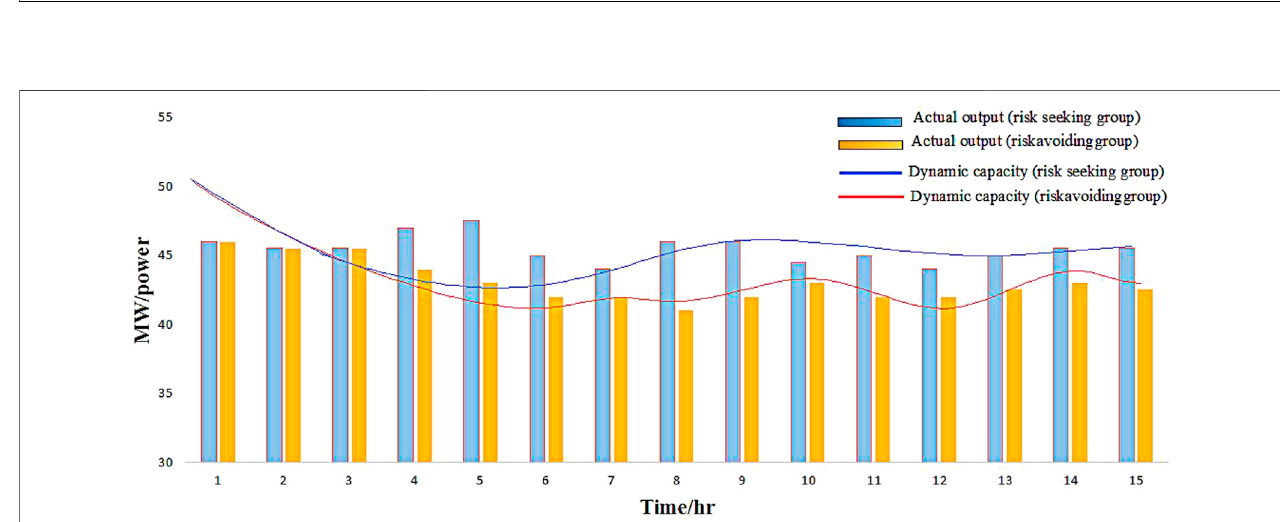
FIGURE 8 | Total output characteristics of VPP under different outdoor temperatures.